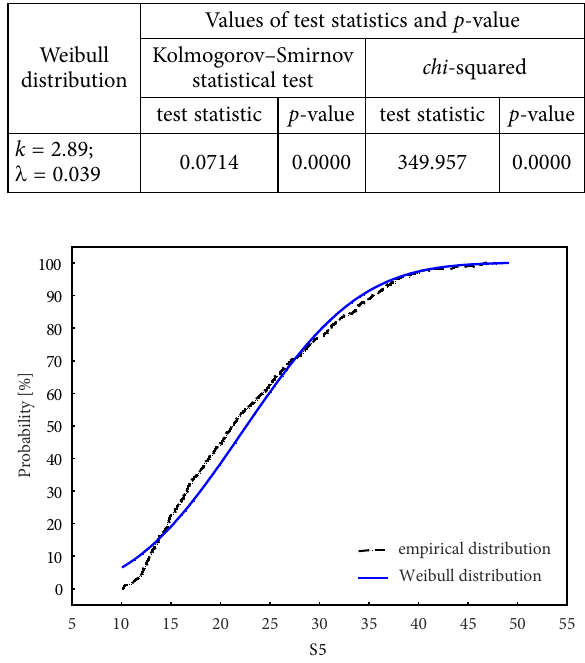
Figure 2. Graph of the empirical and theoretical cumulative distribution function according to the Weibull